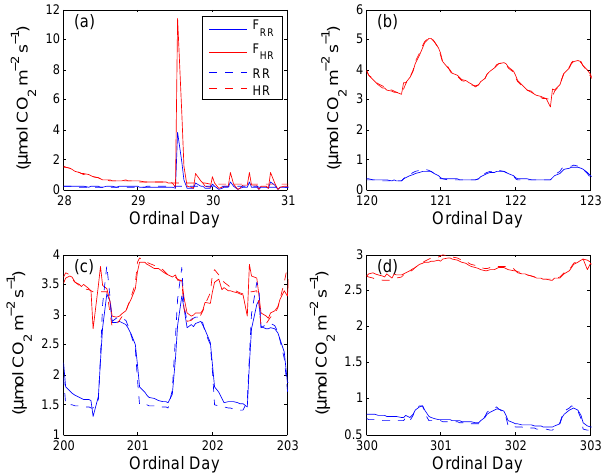
Fig. 9. Comparison of simulated surface CO 2 efflux with their cor- responding belowground production rates at four different time pe- riods. F RR is the surface CO 2 efflux corresponding to that produced from autotrophic root respiration RR. F HR is the surface CO 2 efflux corresponding to that produced from soil heterotrophic respiration